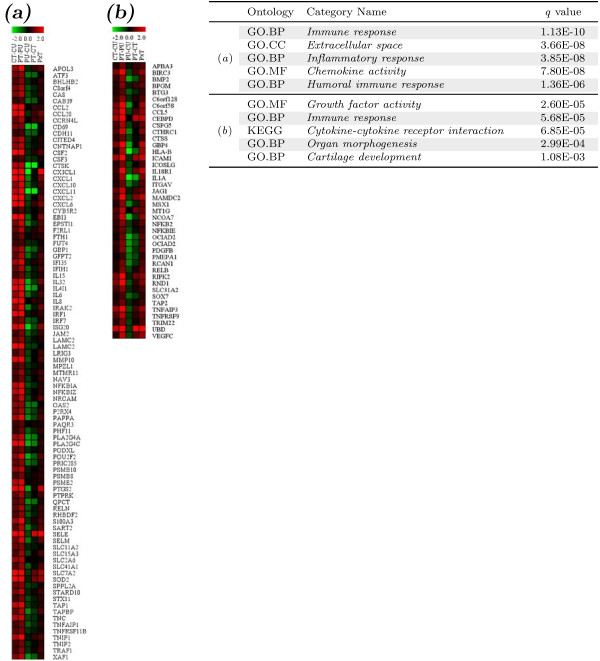
The interactive effects of PML knockdown on TNFα signaling-induced inflammatory response. (a and b) Two clusters of genes annotated with inflammation-associated ontology information were identified in a clustering analysis of the log fold change values of significantly affected genes combined with their gene ontology information (GO and KEGG). The affected categories of ontology information and the Fisher exact test results are summarized in the table. “CT-CU”, TNFα effects with control siRNA transfection; “PT-PU”, TNFα effects with PML siRNAs transfected; “PU-CU”, PML knockdown effects; “PT-CT”, PML knockdown effects when TNFα treated; “PxT”, the interaction effects of PML knockdown and TNFα treatment defined as P×T = (PT−PU)−(CT−CU)=(PT−CT)−(PU−CU). GO, Gene Ontology database; BP, biological function; CC, cellular component; MF, molecular function; KEGG, Kyoto Encyclopedia of Genes and Genomes.